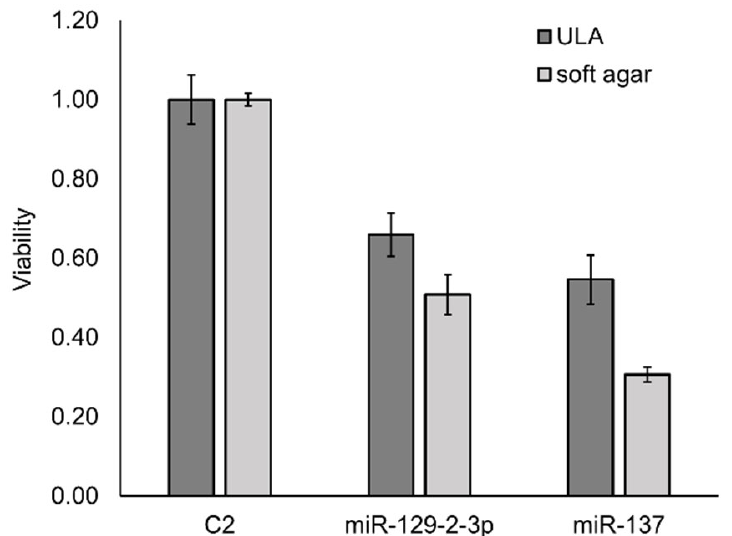
Figure 1. ULA plates show similar growth reduction compared to soft-agar assays. Bar graph demonstrating comparable results for a cell viability assay using ULA plates and colony counts in a soft-agar assay for SiHa cells ectopically expressing miR-129-2-3p or miR-137, relative to negative control C2. The standard error was calculated based on at least two measurements. Next, we proceeded with a genome-wide functional screen on SiHa cells using the miRIDIAN miRNA mimic library comprising 2019 miRNA mimics. The data were log-2 transformed and visualized in boxplots to select the most suitable positive control for the data normalization. The strongest effect on cell viability was measured for UBB siRNA followed by miRNA mimics miR-137 and miR-129-2-3p, as shown in Supplementary Figure S1A. Cell viability data from the miRNA mimics library yielded mostly values fitting between the negative control C2 and the positive control miR-137 (Supplementary Figure S1B). Therefore, these were used to calculate viability scores, representing normalized log2-values relative to the controls. The negative control was centered at zero (no change in viability) and the positive control (miR-137) at -1. Based on a false discovery rates (FDR) <0.01 we identified 87 miRNAs significantly affecting the growth of SiHa cells in ULA plates, 84 of which were decreasing growth (values <0), and 3 were increasing the growth (values >0) (Figure 2). As expected, miR-137 and miR-129-5p in the library were also identified amongst the 84 miRNAs reducing growth on ULA plates. The complete data set is presented in Supplementary File